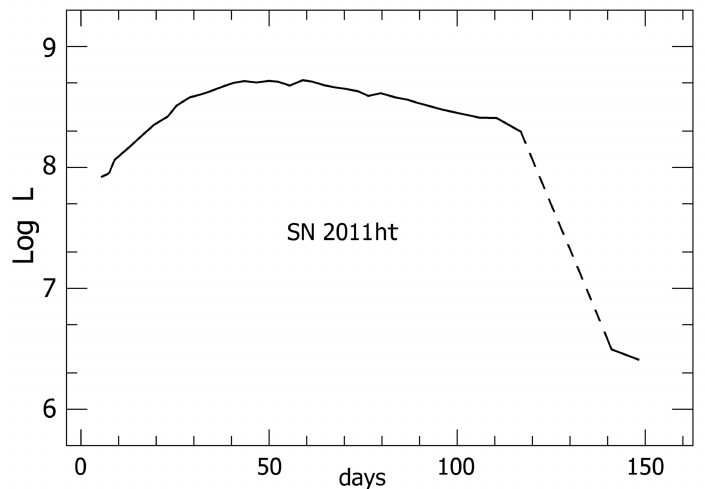
Figure 2. Luminosity record of SN2011ht based on visual-wavelength brightness [42]. The vertical scale, expressed in solar units, neglects variations in the bolometric correction but is adequate for conceptual purposes. The relative faintness after t ∼ 130 d is highly abnormal if this object was a true supernova.